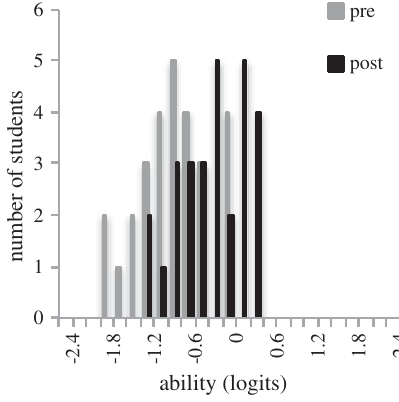
FIG. 36. The pre- and postability histogram for class 22.